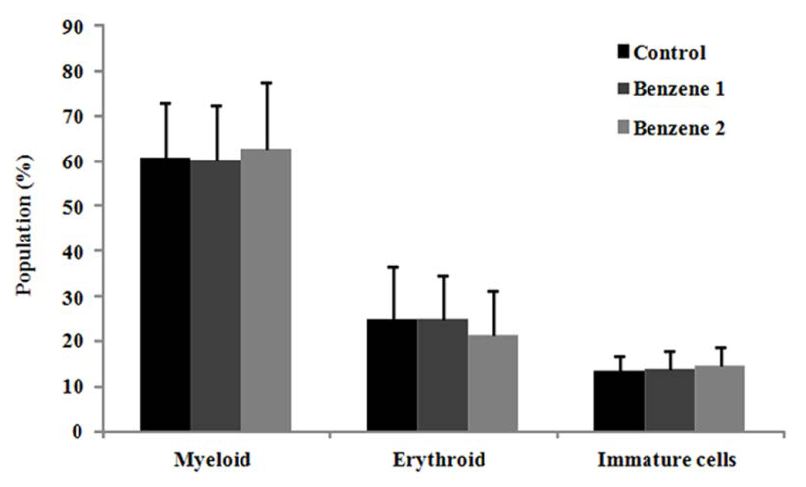
Figure 2. Bone marrow smear examination of mice at 10 months post-benzene